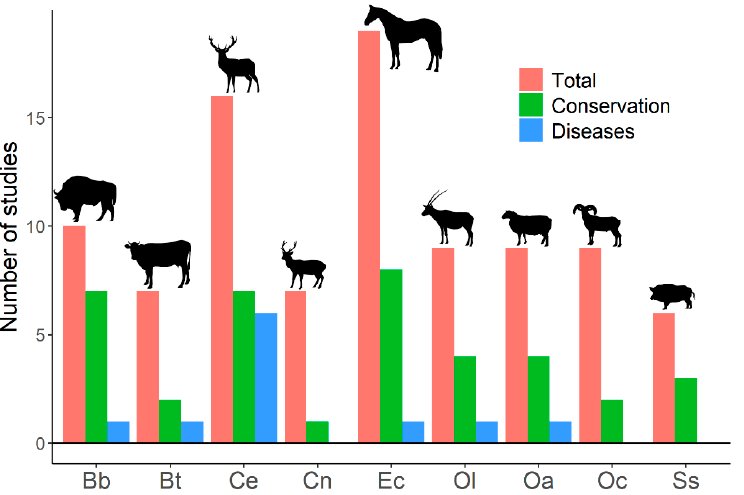
Figure 1. Number of published studies on genetic diversity for the most frequently studied ungulates. Results from a search on the Web of Science with the following search terms: genetic diversity, inbreeding, and ungulates (217 studies were obtained). Studies on genetic diversity of ungulate populations published in scientific journals were selected (204 papers). Total: number of studies on genetic diversity of ungulate populations published in scientific journals. Conservation: number of studies that explicitly related genetic diversity to conservation (papers in which the word ‘conservation’ appeared in the title, abstract, or the name of the journal). Diseases: number of studies that explicitly associated genetic diversity with diseases (papers in which the title, abstract, or name of the journal used at least one of the following terms: ‘disease’, ‘pathogen’, ‘parasite’, any variation of ‘immunity’, or the name of any disease). Bb: Bison bonasus , Bt: Bos taurus , Ce: Cervus elaphus , Cn: Cervus nippon